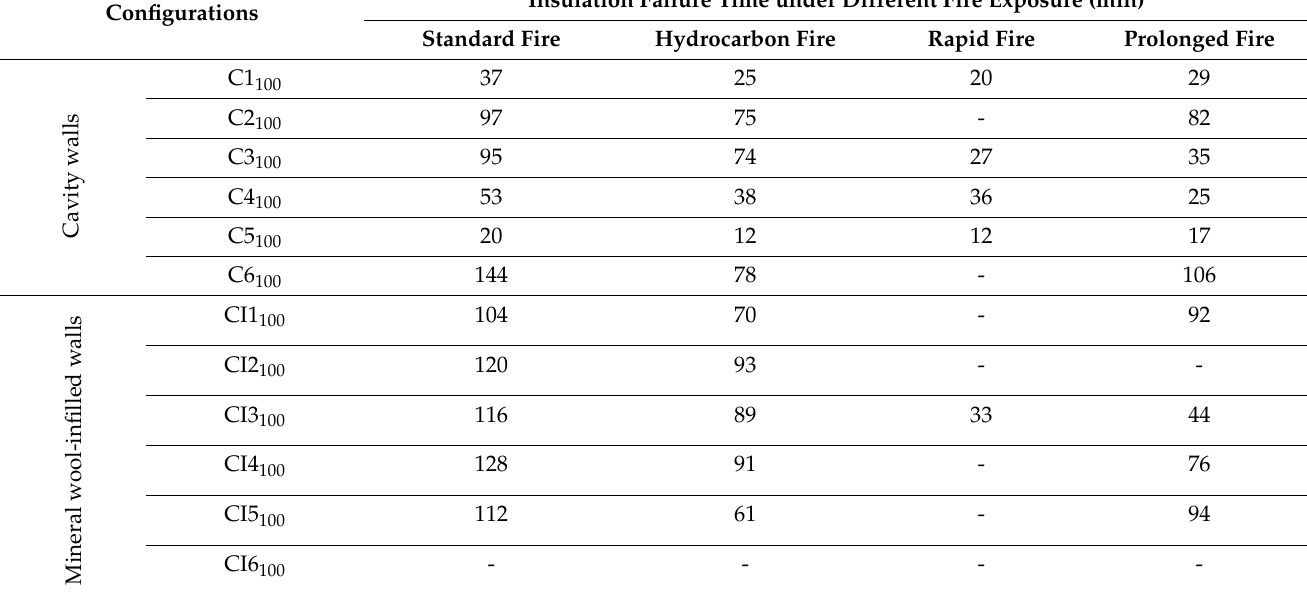
Table 5. Insulation fire ratings for 3D-printed concrete walls (100 mm series).